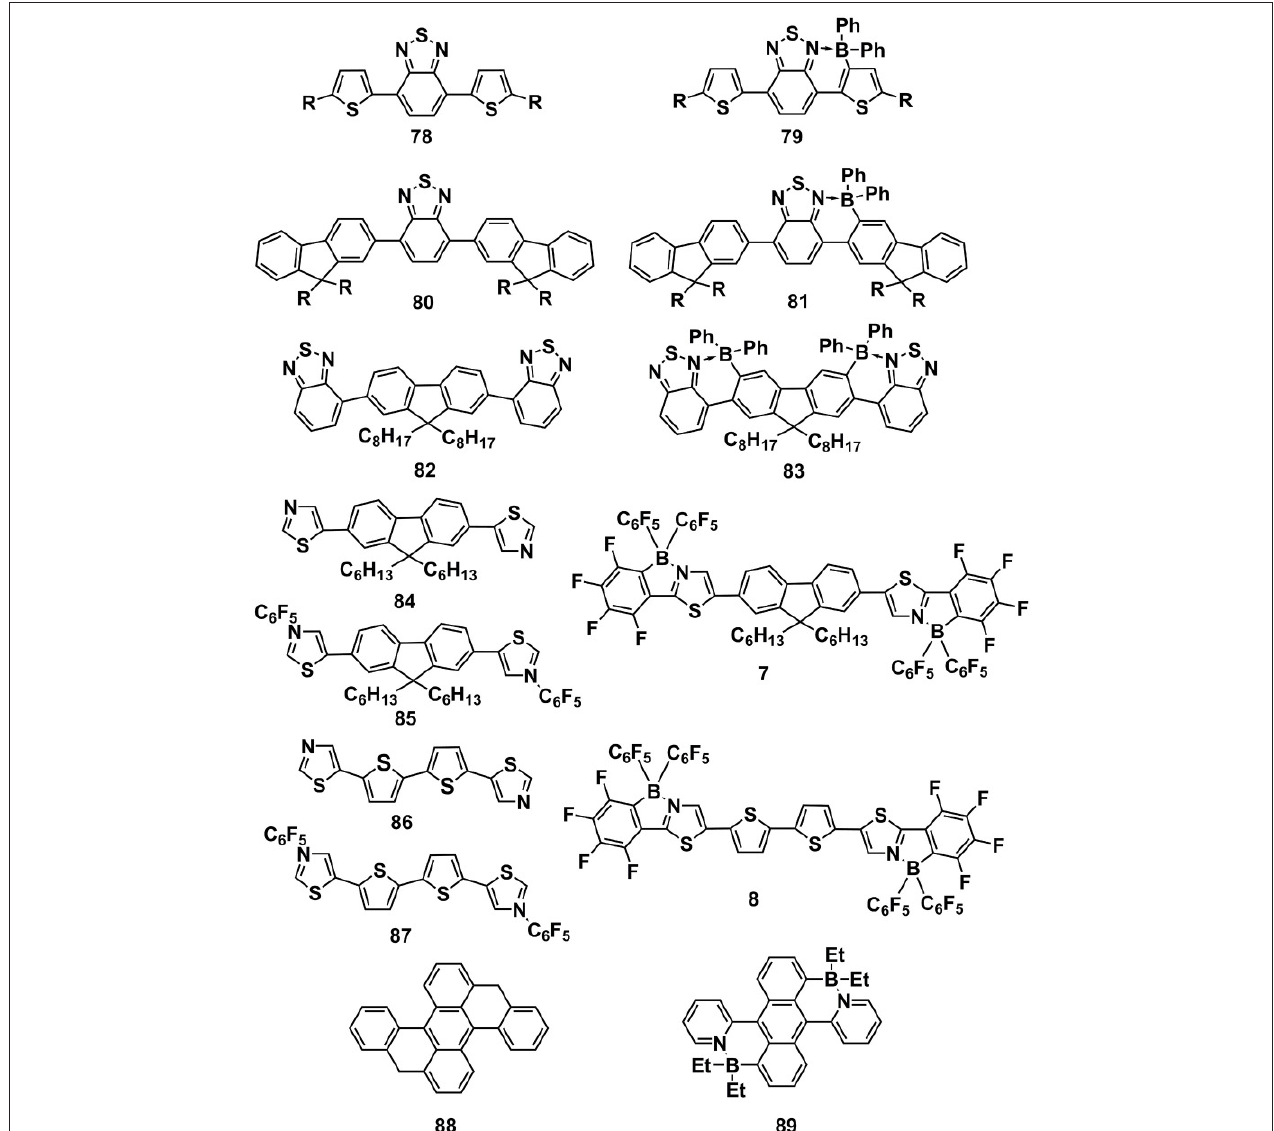
FIGURE 9 | Molecular structures of B ← N embedded π -units and their precursors before